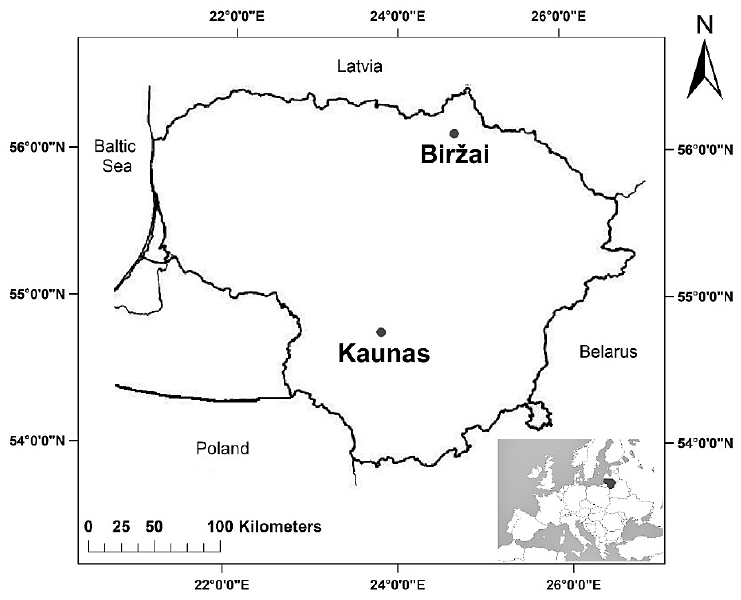
Fig. 1. Location of experimental sites in